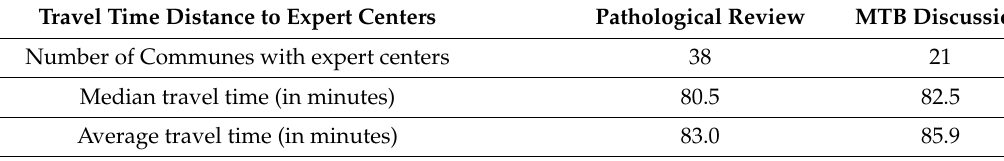
Table 2. Remoteness and geographical inequalities in the access to sarcoma expertise for patients from mainland France.